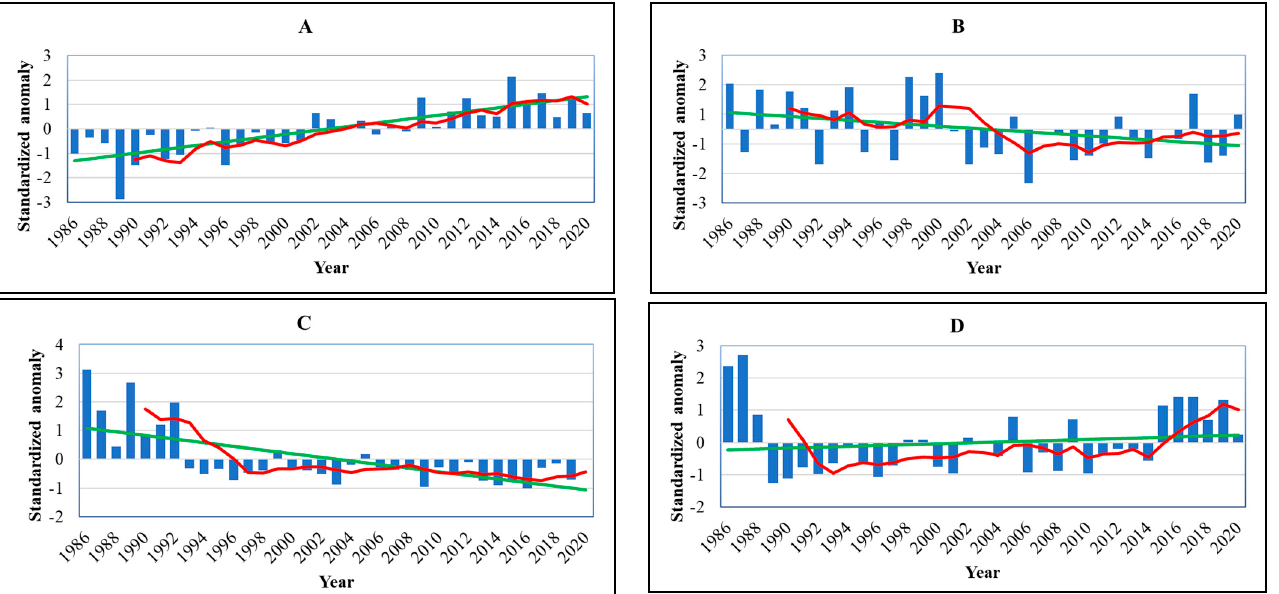
Figure 11. Time series diagram of the mean country-wide extreme temperature indices in the time period between 1986 and 2020: ( A ) SU25, ( B ) FD0, ( C ) CSDI, and ( D ) WSDI. Note: The straight green line is the linear trend for the variables, while the red curved line is the five-year moving average.